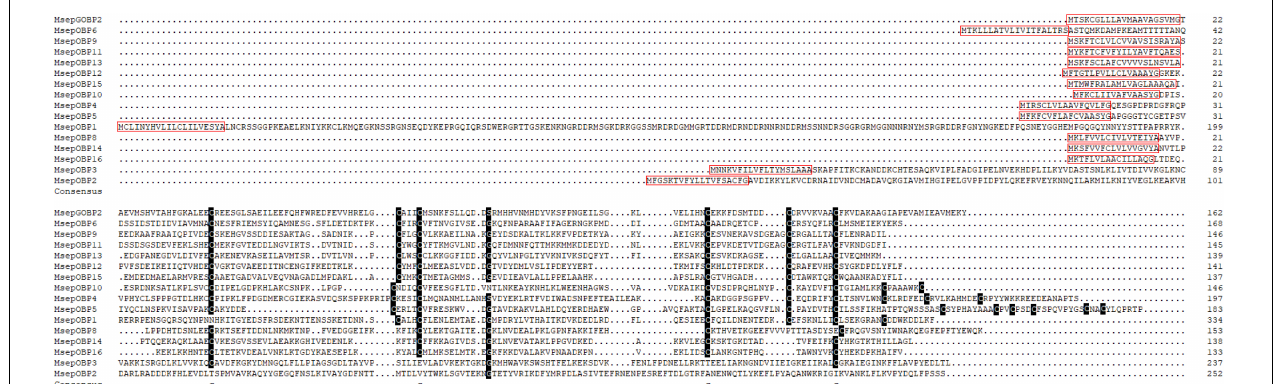
FIGURE 3 | Multiple alignment of amino acid sequences of OBPs from M. separata. In the sequence alignments, only the proteins with full-length ORFs were selected. Conserved cysteine residues are highlighted, and signal peptides are boxed in